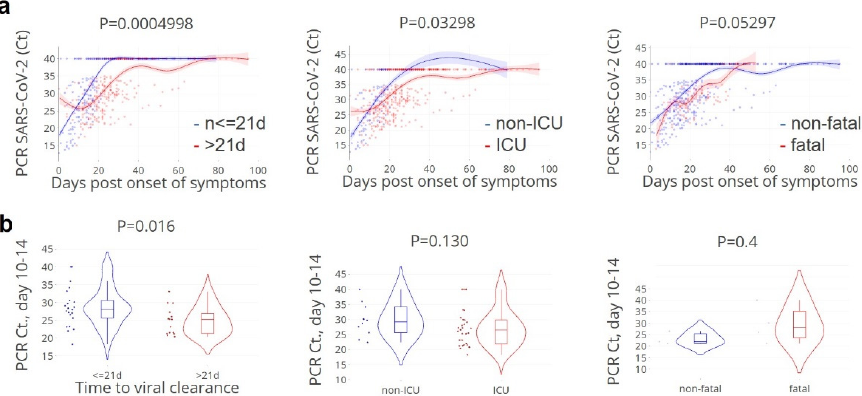
Figure 2. Higher SARS-CoV-2 loads, over time are associated with ICU admission and fatality. ( a ). kinetics in relation to the time post onset of symptoms (days), per patient per groups with rapid: ≤ 21 days (blue lines/dots) and delayed: > 21 days viral clearance (red lines/dots), ICU admission, and fatality. Lines indicate non-linear group trends. Spline regression with bootstrap confidence intervals. ( b ). Mean datapoints at day 10–14 data per patient, grouped according to the time to viral clearance ≤ 21 days (blue)/> 21 days (red), ICU admittance, and fatality, respectively. n = 91 patients. Mann–Whitney U test.